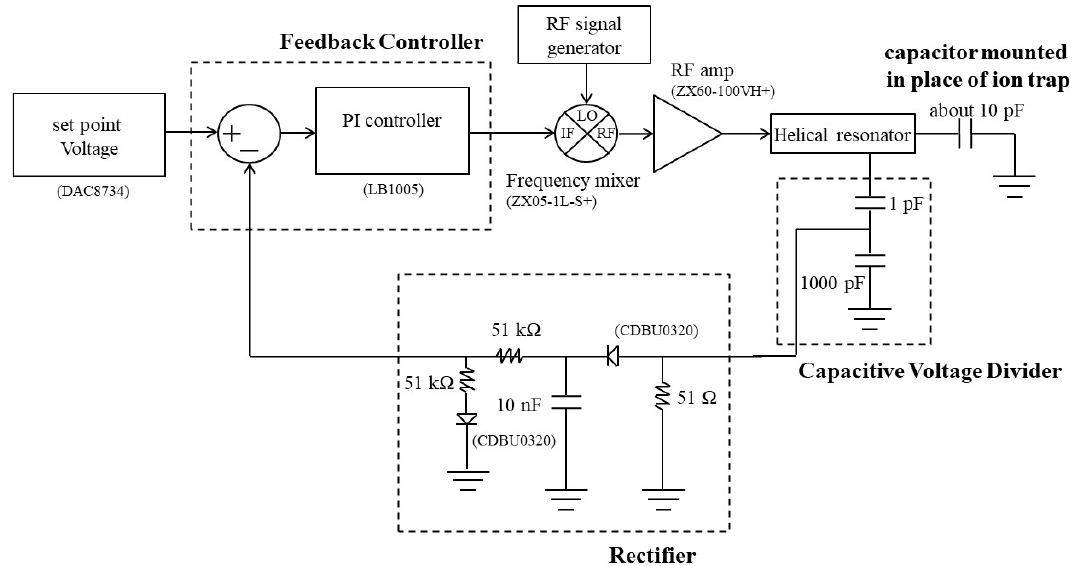
Figure 2. A block diagram of the closed-loop feedback control system for reducing the fluctuation of the amplitude of the RF signal, using a commercial universal proportional-plus-integral (PI) controller.